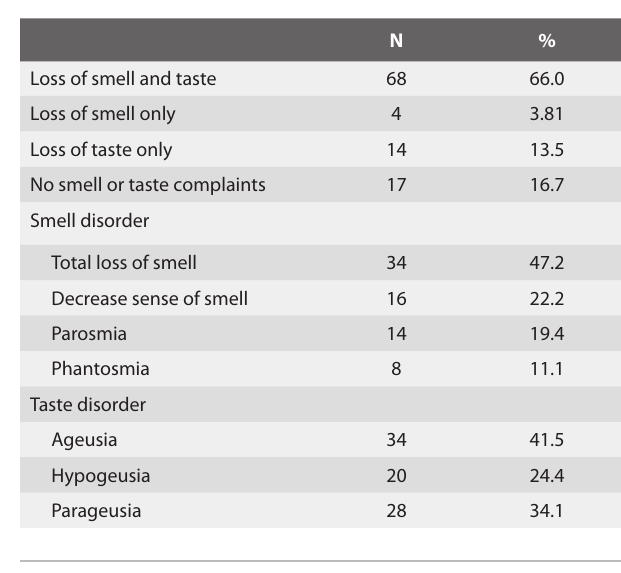
Table 2. Smell and taste